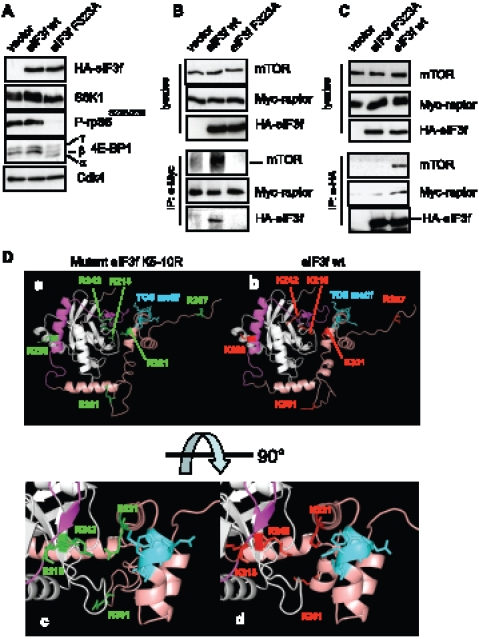
A TOS motif in eIF3f is necessary for binding to mTOR-raptor.(A) Effects of TOS mutation on the activity of mTORC1. Mouse
primary muscle cells were transfected with expression vectors encoding
HA-tagged eIF3f wt, HA-tagged TOS motif mutant eIF3f F323A and the empty
vector. At 24h post-transfection cells were induced to differentiate.
Protein expression and phosphorylation levels were assayed from lysates
of 4 days differentiated myotubes by immunoblotting. (B)
Mouse primary muscle cells were co-transfected with expresion vector
encoding Myc-raptor and either HA-eIF3f wt, the TOS motif mutant
HA-eIF3f F323A and/or the empty vector. Transfected cells were induced
to differentiate during 4 days and lysed in immunoprecipitation buffer
without detergent. Total cellular extracts were subjected to
immunoprecipitation with anti-Myc antibody, followed by immnoblotting.
Asterisk indicates a non specific band . (C) Mouse primary
muscle cells were transfected, differentiated and lysed as indicated in B. Total cellular extracts were subjected to immunoprecipitation
with anti-HA antibody, followed byimmunoblotting. (D)
Modeling of eIF3f shows that the functional TOS is accessible for
eIF3f/raptor interaction. Models of the three-dimensional structures of
wild type and mutant eIF3f K5-10R. The left-side images correspond to
mutant eIF3f K5–10R (panels a and c), right-side to
eIF3f wt (panels b and d). The mutated lysines are coloured red, and
corresponding arginines are colored green. The C-terminal arm is colored
salmon. The mTOR binding region is colored pink. The TOS motif is
colored blue. The bottom panel is a zoom on the central region in a
90° rotation.